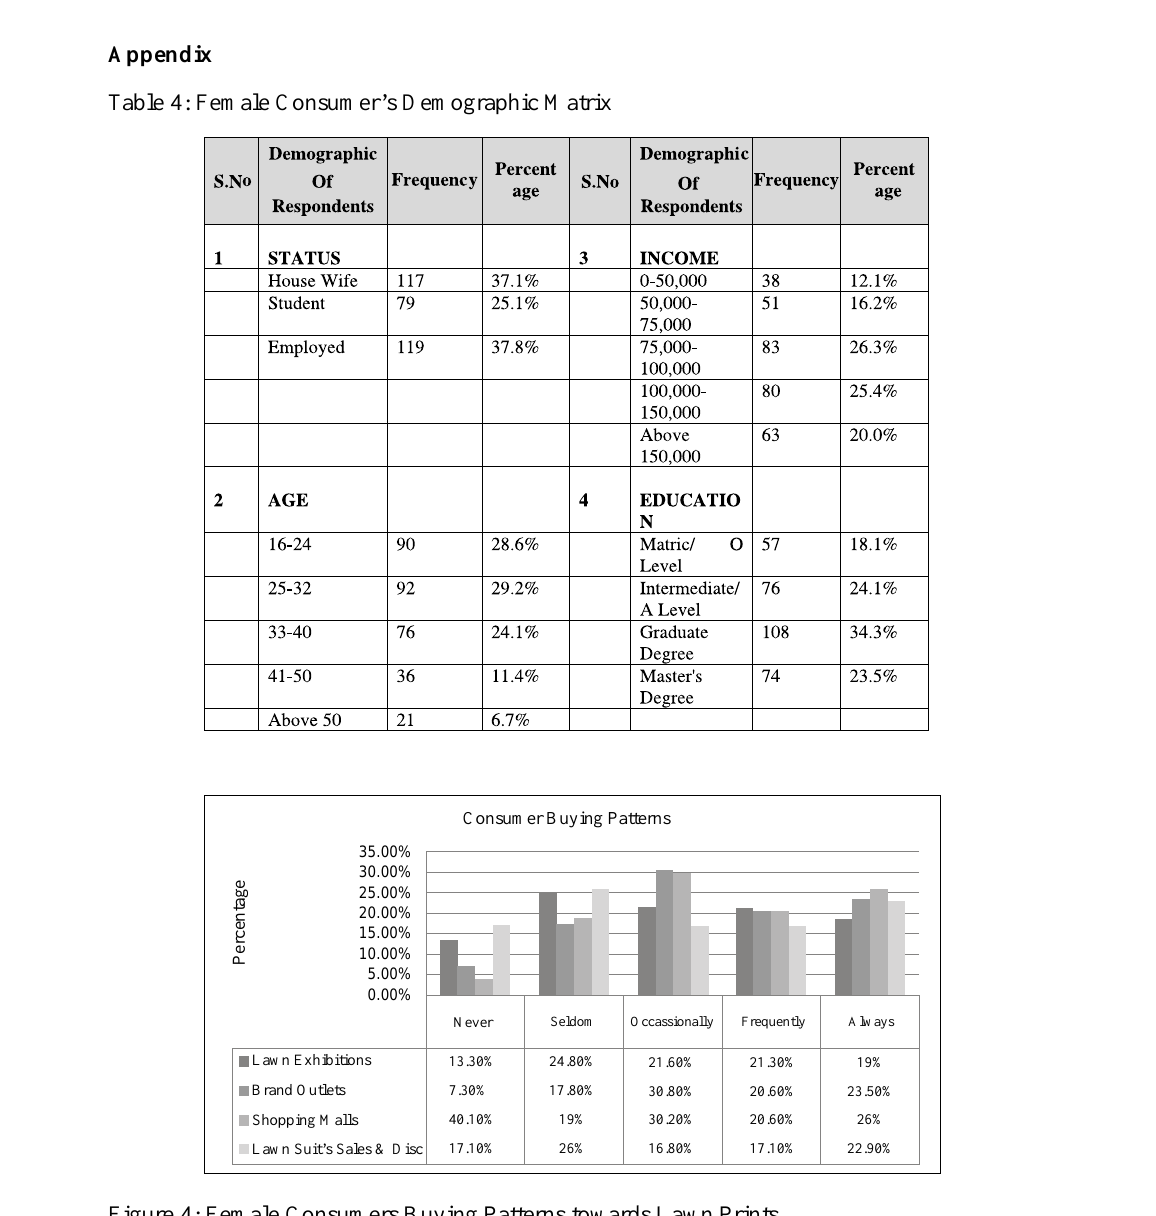
Figure 4: Female Consumers Buying Patterns towards Lawn